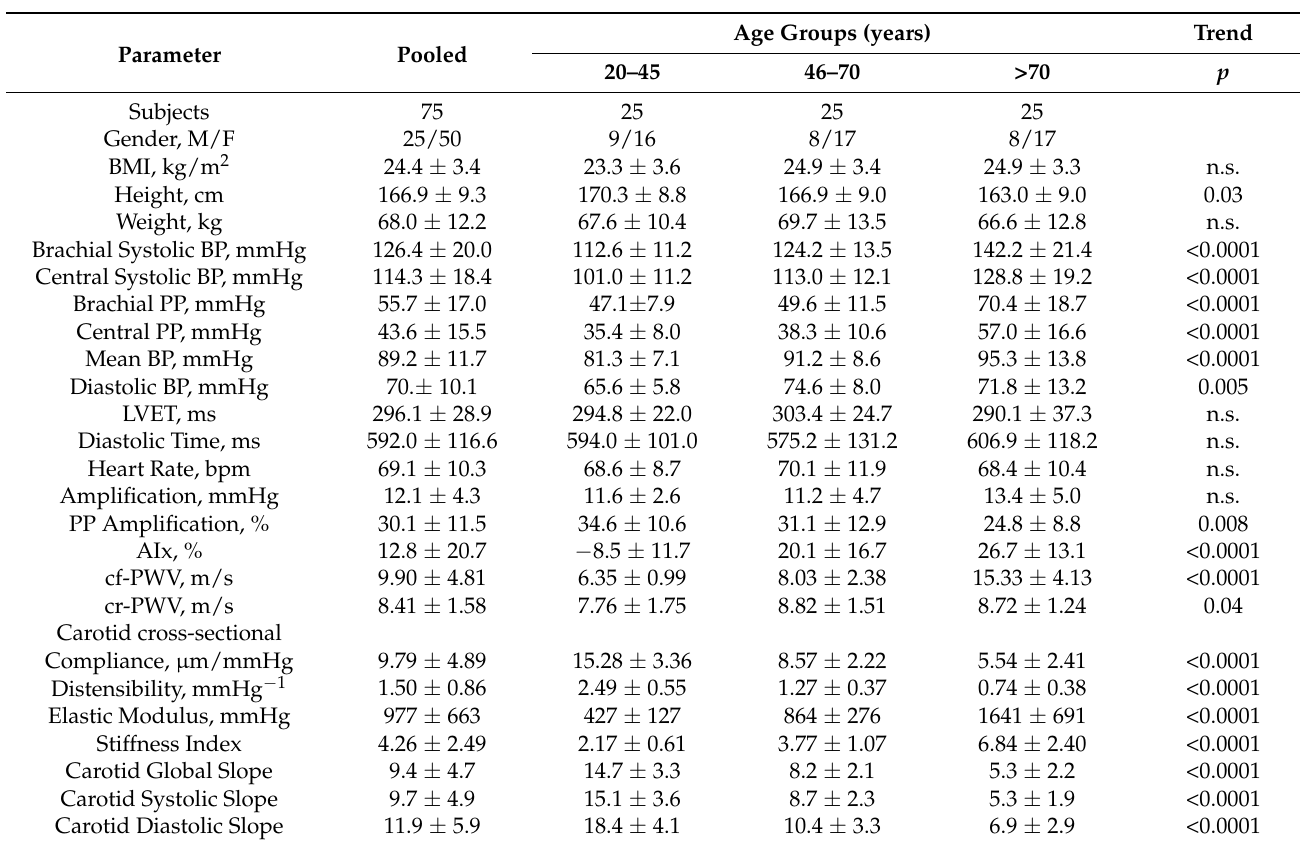
Table 1. Clinical, anthropometric, and hemodynamic